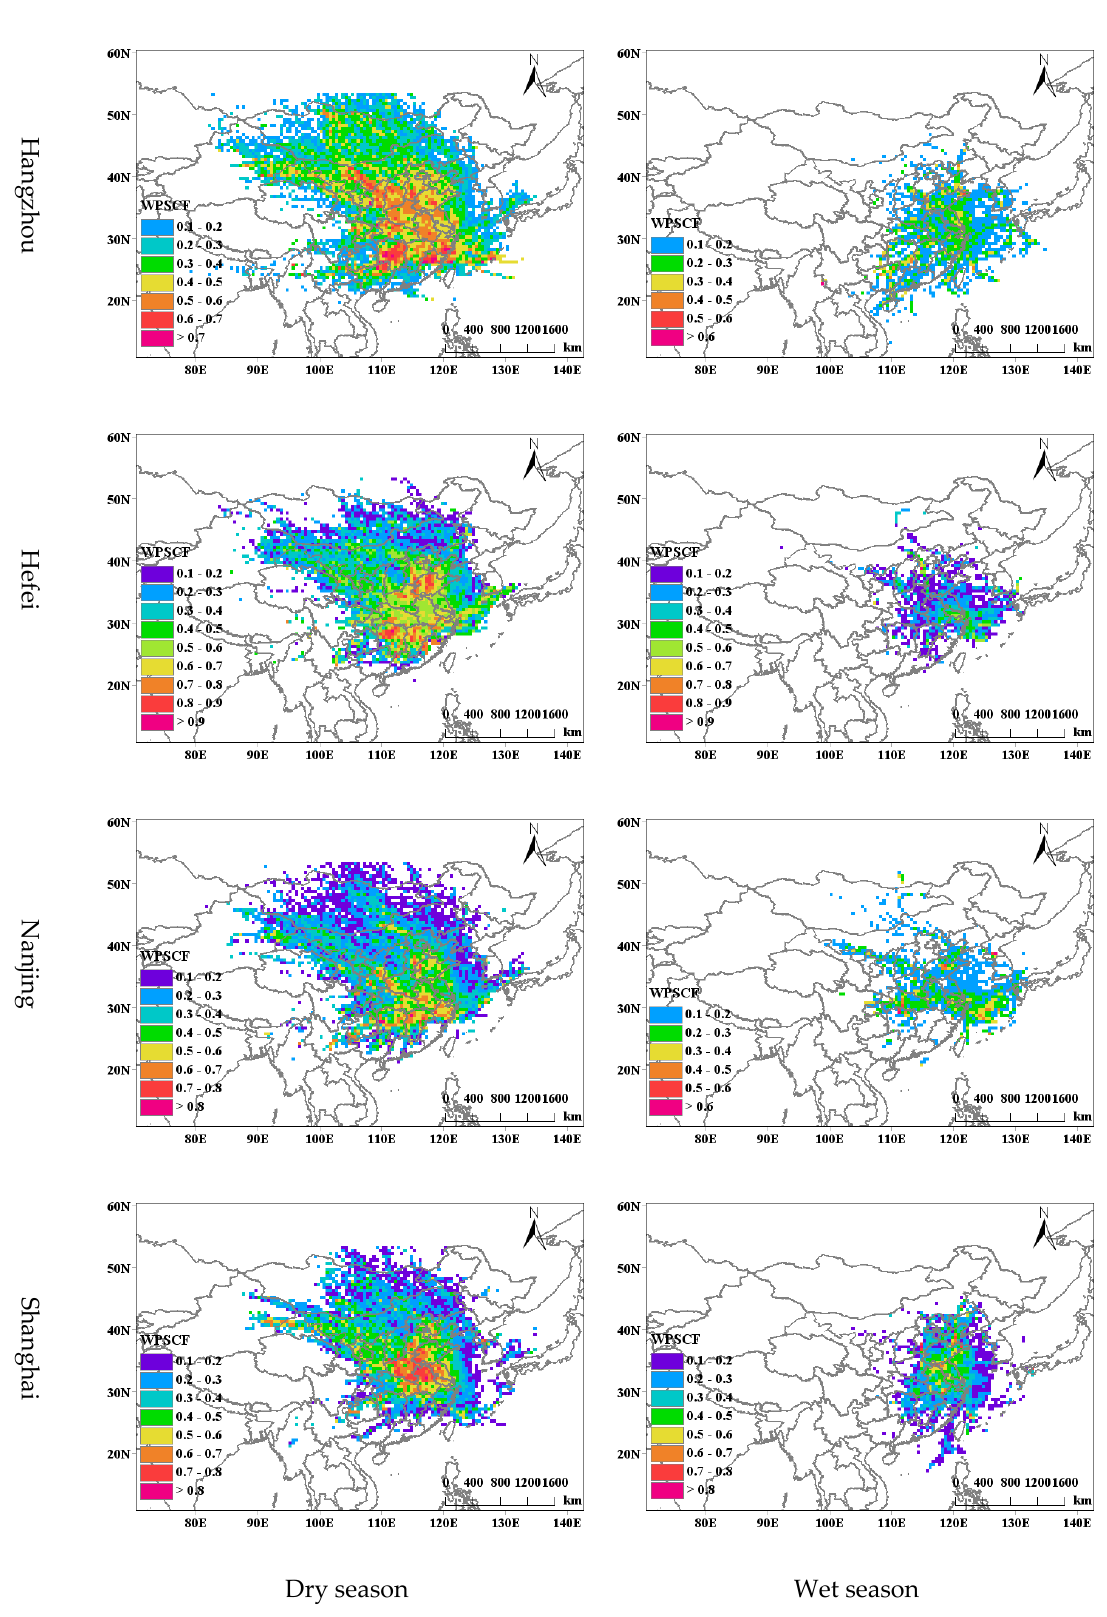
Figure 5. Weighted potential source contribution for PM 2.5 in dry and wet seasons in the YRDUA.